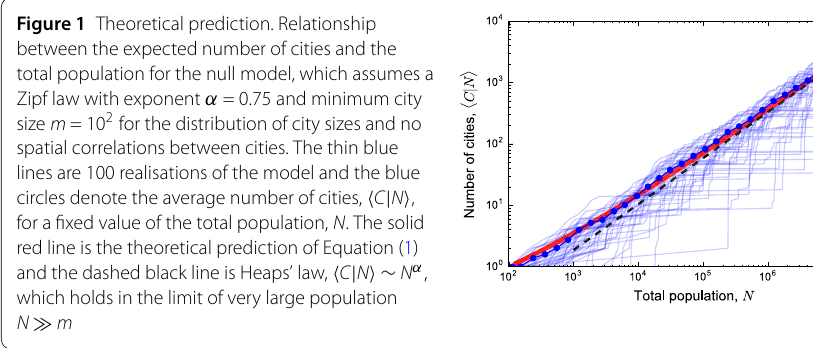
Figure 1 Theoretical prediction. Relationship between the expected number of cities and the total population for the null model, which assumes a Zipf law with exponent α = 0.75 and minimum city size m = 10 2 for the distribution of city sizes and no spatial correlations between cities. The thin blue lines are 100 realisations of the model and the blue circles denote the average number of cities, (cid:5) C | N (cid:6) , for a fixed value of the total population, N . The solid red line is the theoretical prediction of Equation (1) and the dashed black line is Heaps’ law, (cid:5) C | N (cid:6) ∼ N α , which holds in the limit of very large population N (cid:7)